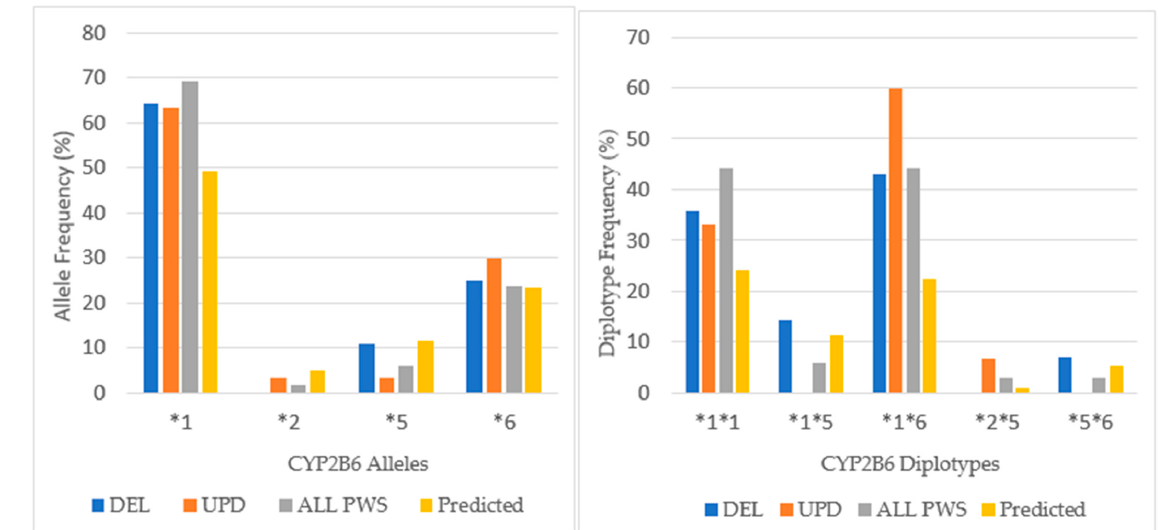
Figure 7. Cytochrome 2B6 allele frequency and diplotype distribution in a referred cohort with PWS DEL ( n = 14), UPD ( n = 15) and combined cohort (ALL PWS, n = 34) compared to the predicted, European normative data [http://www.phar- mgkb.org/page/cyp2b6RefMaterials].